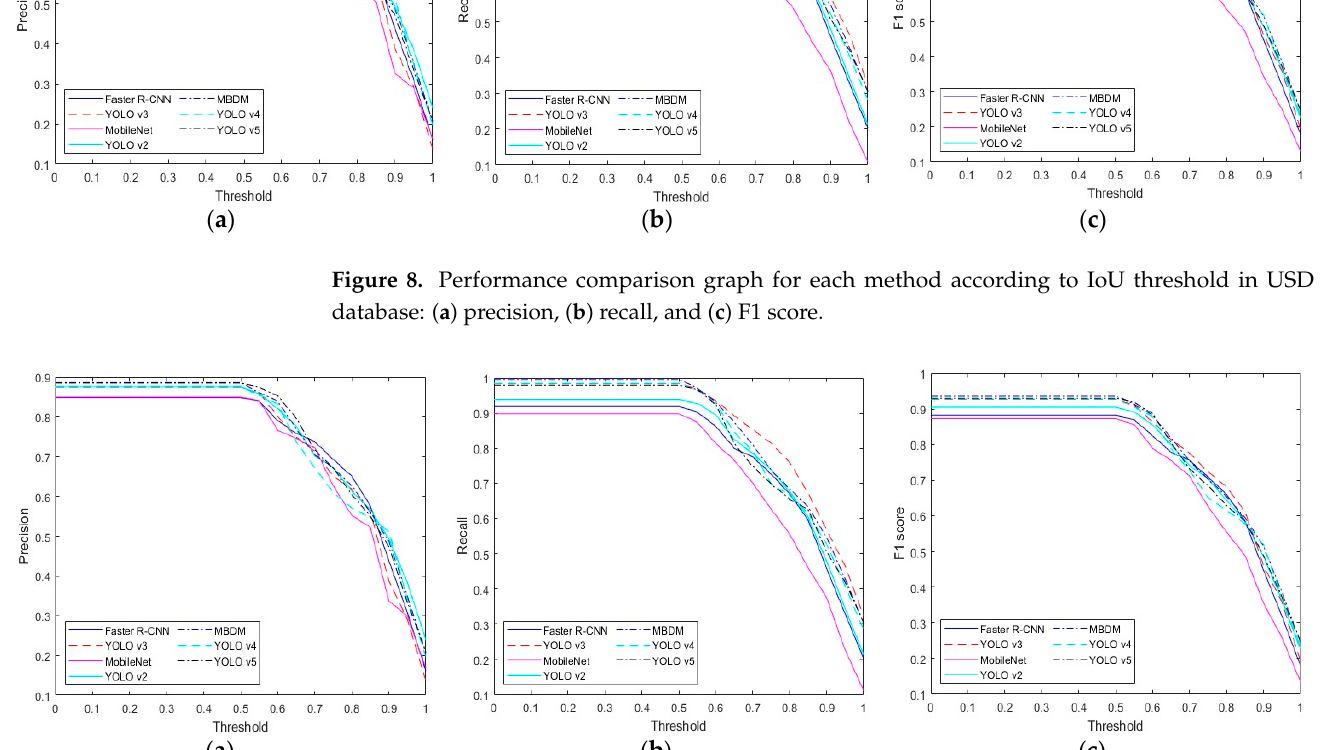
Figure 9. Performance comparison graph for each method according to IoU threshold in EUR database: ( a ) precision, ( b ) recall, and ( c ) F1 score.